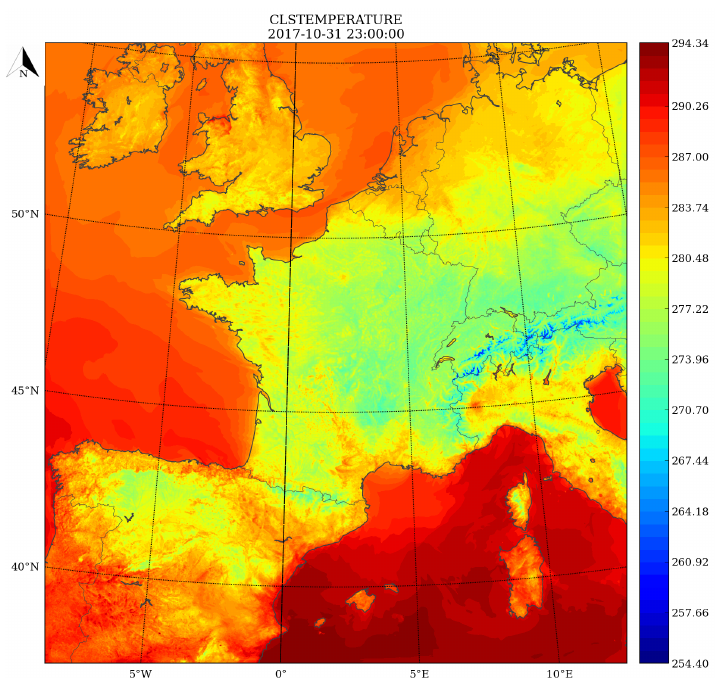
Figure 1. AROME-France domain (2-m air temperature (K) for 31 October 2017, 23 UTC).